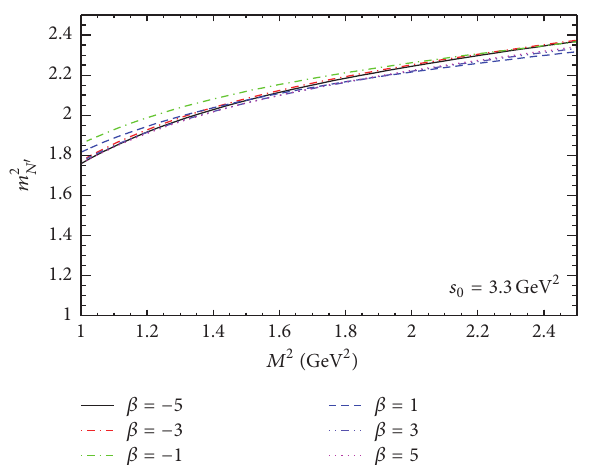
Figure 3: Dependence of 𝑚 2 𝑁 󸀠 on cos 𝜃 at the fixed value of the continuum threshold 𝑠 0 = 3.3 GeV 2 is shown for various values of the Borel mass parameter 𝑀 2 .